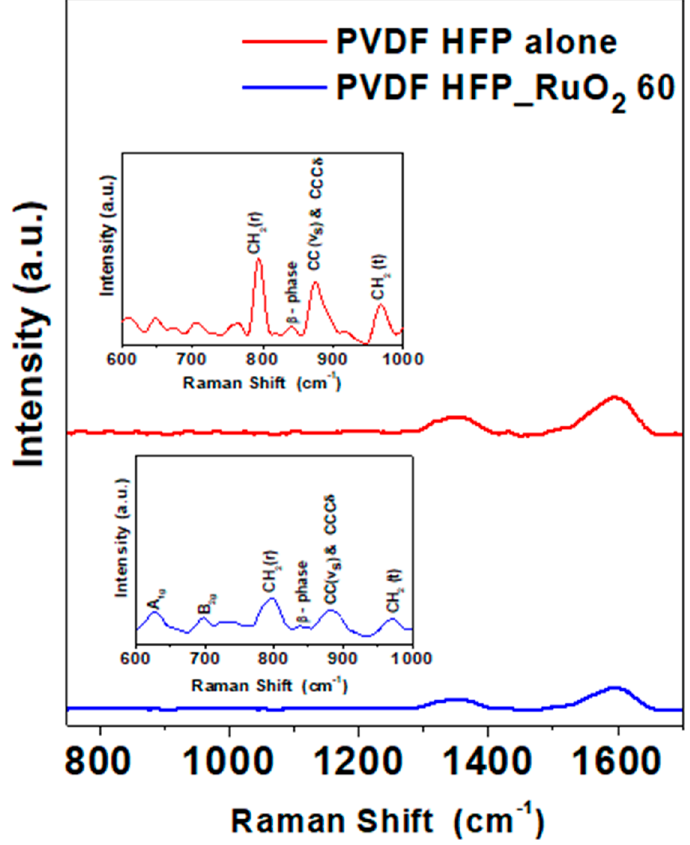
Figure 8. Raman spectra of PVDF HFP aerogel alone (red line) and of PVDF HFP_RuO 2 60 (blue line).